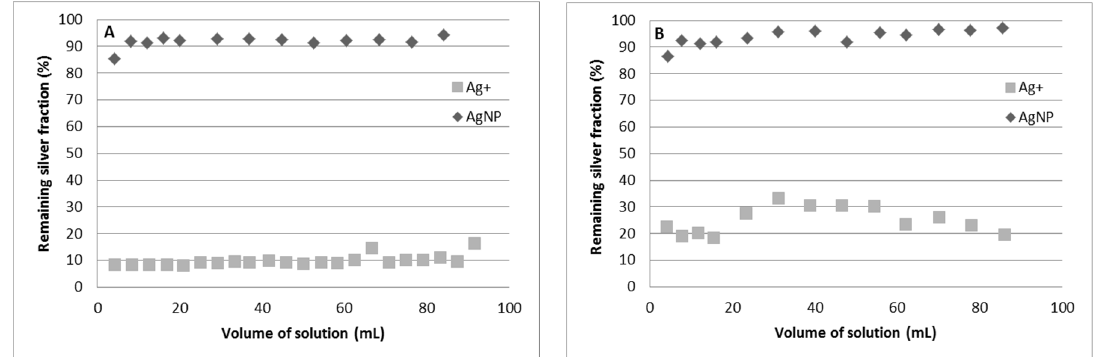
Figure 7. Remaining silver fraction (Ag + or AgNPs) in column experiments using River Water 2 as matrix. ( A ) New resin. ( B ) Reconditioned resin. Silver concentration: 100 μg·kg − 1 ; Flow rate: 1.3 mL·min − 1 ; Amount of resin: 0.5 g.